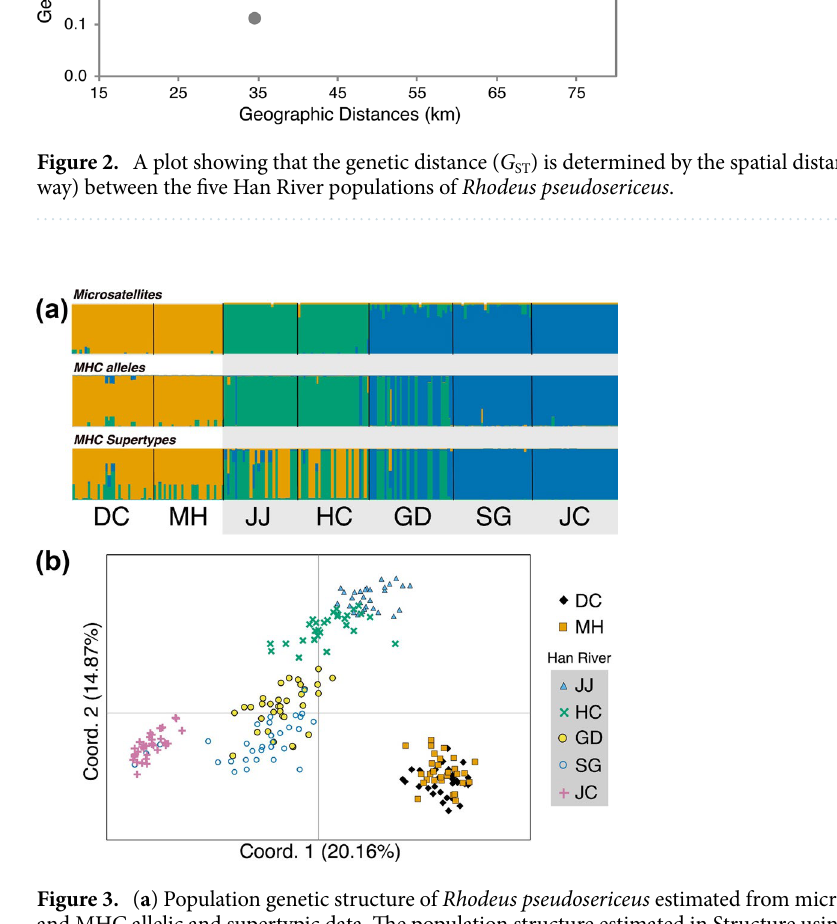
differentiation was observed between DC-MH and the Han River populations, and the Han River populations were likely subdivided into two groups (JJ-HC, JC-SG-GD; Fig. 3a). Upon PCA analysis, these three genetic groups were also identified (Fig. 3b).